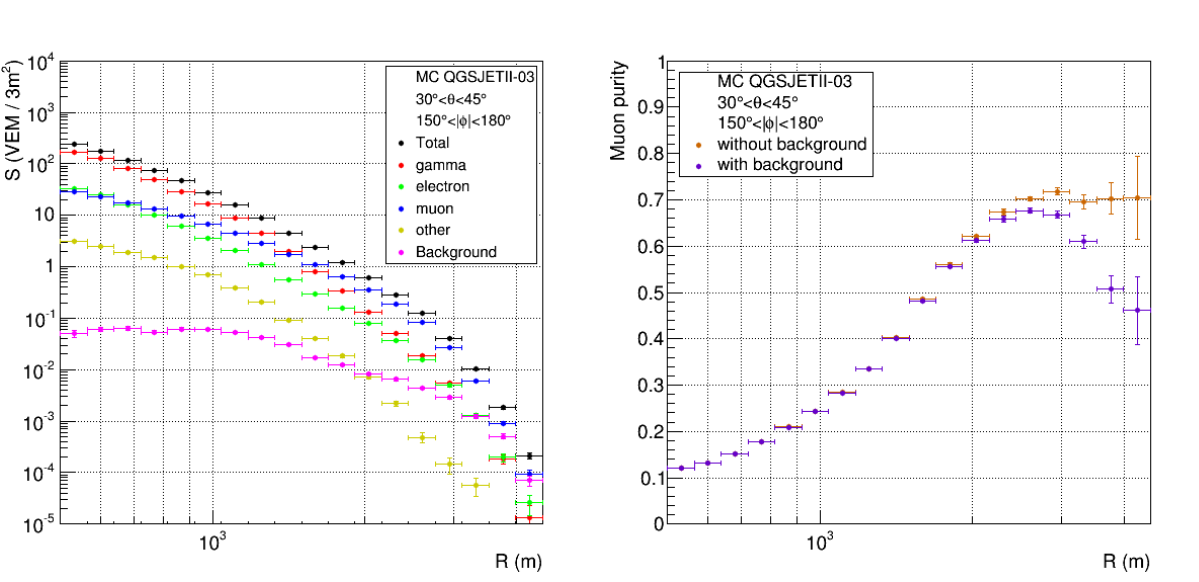
Figure 2. Lateral distributions of the air shower MC with QGSJET II-03 for 30 ◦ < (cid:18) < 45 ◦ ; 150 ◦ < j ϕ j < 180 ◦ , 500 m < R < 4500 m [28]. (left) The signal size for each particle type. The vertical error bar shows the standard deviation. (right) The muon purity. The violet and orange dots show results calculated with and without the atmospheric muon background,